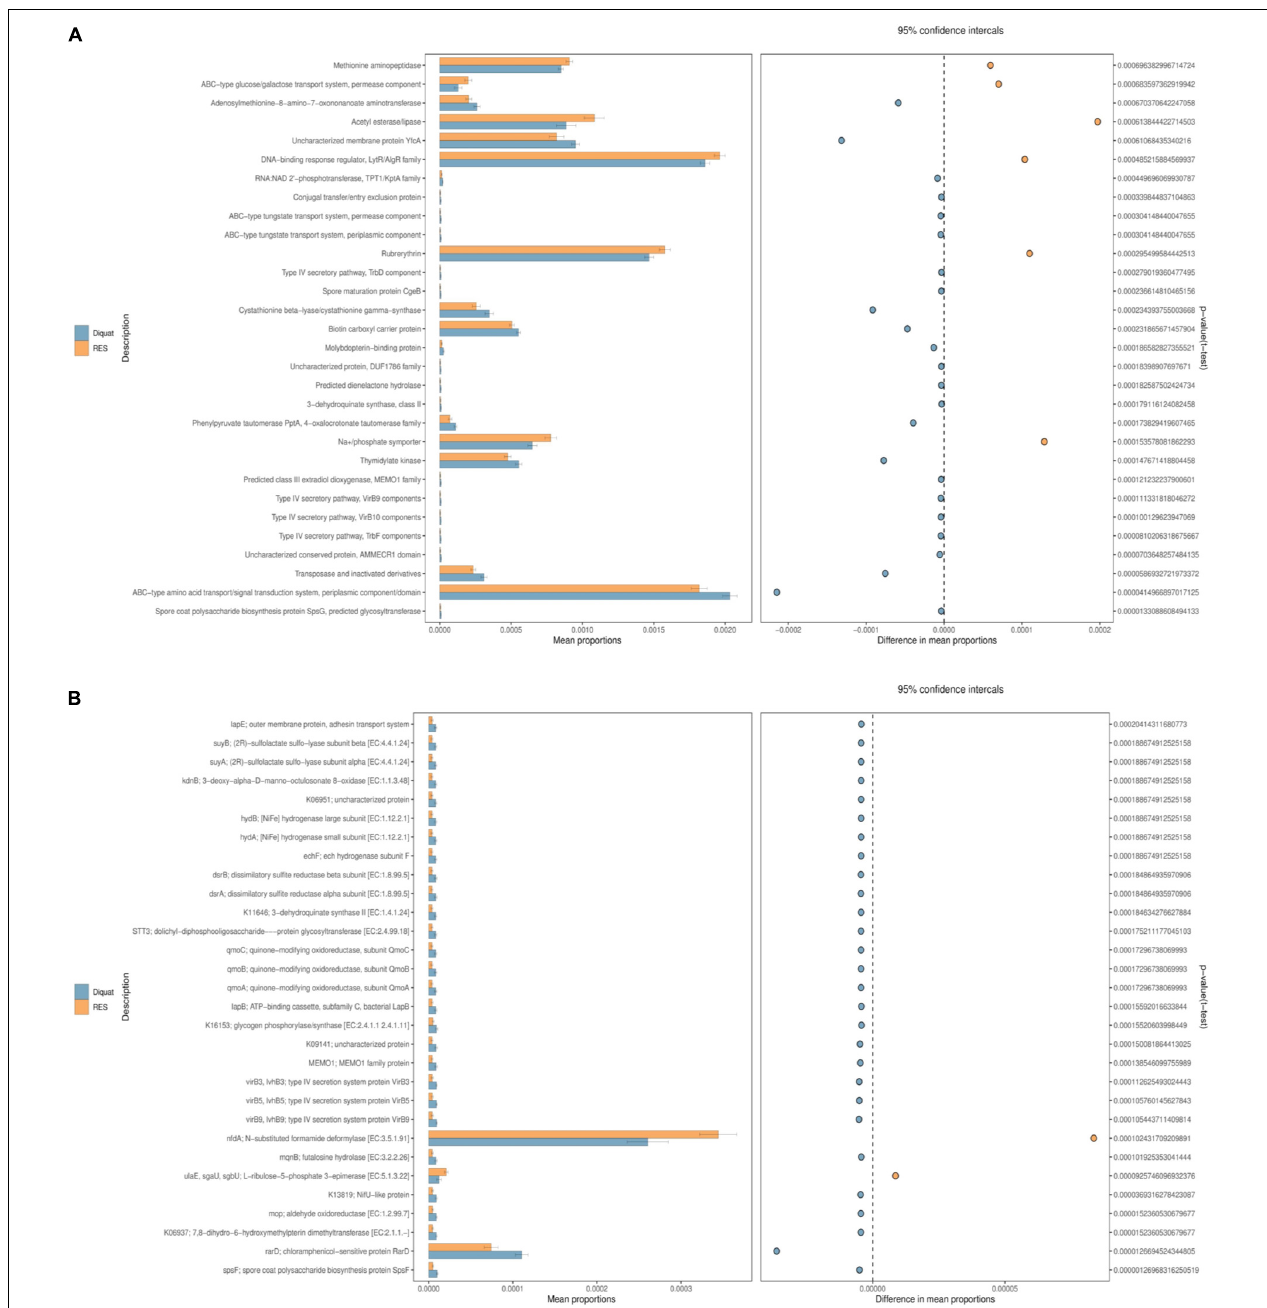
FIGURE 4 | Gut microbiome comparison of PICRUSt-predicted functional pathway analysis. (A,B) Phylogenetic Investigation of Communities by Reconstruction of Unobserved States (PICRUSt2), which will be used to analysis of the difference of COG (A) and KO (B) metabolic pathway between diquat and RES groups at the second